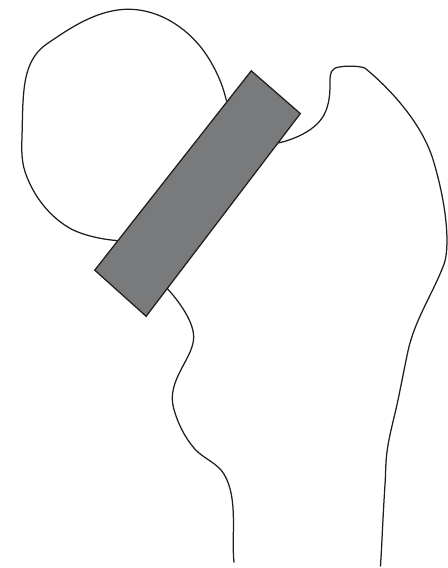
Figure 1: Femoral neck region of interest, derived from the Hologic QDR 4500 Operator’s